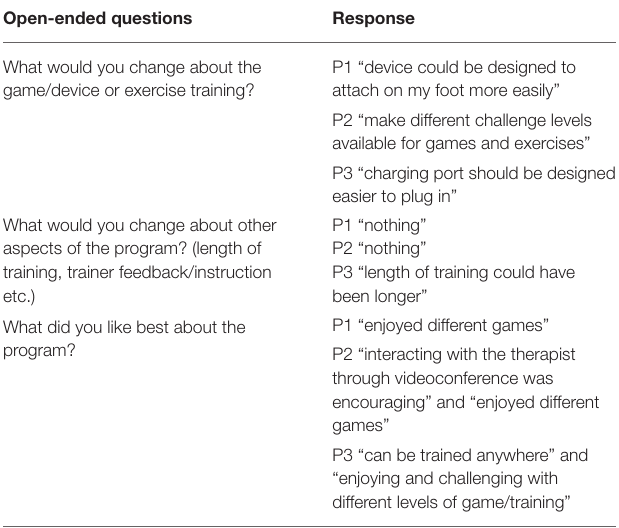
TABLE 2 | Participant acceptability of the telerehabilitation protocol.